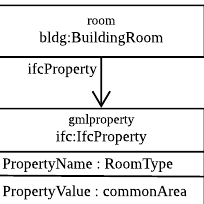
Figure 3. An instance of a BuildingRoom node with an IfcProperty node in the CityGML object graph.